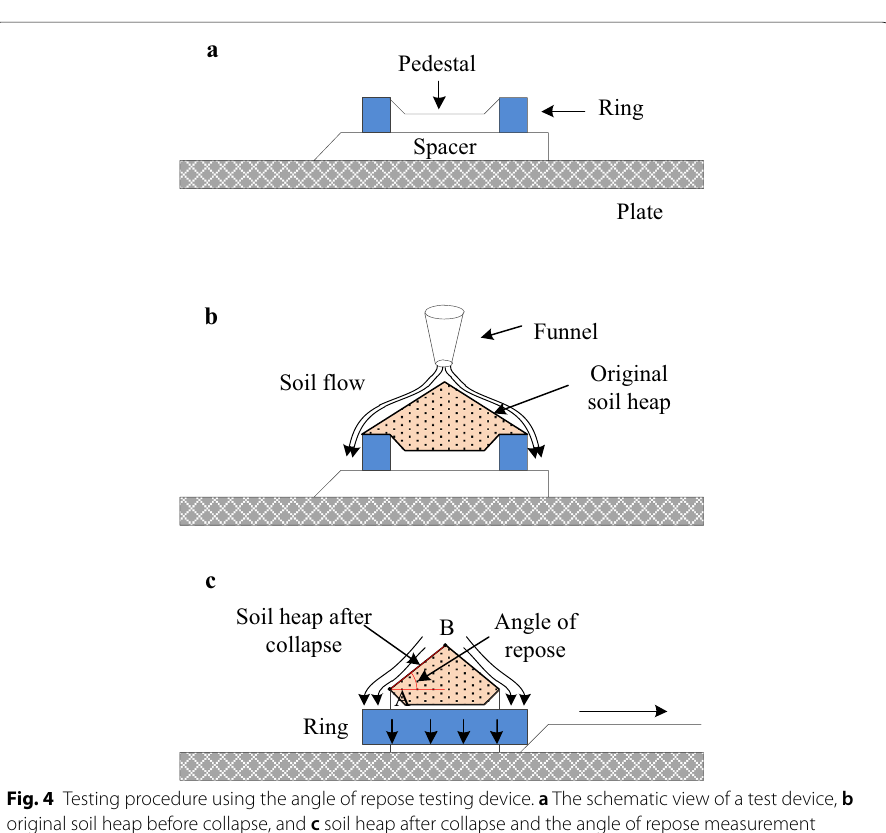
Fig. 4 Testing procedure using the angle of repose testing device. a The schematic view of a test device, b original soil heap before collapse, and c soil heap after collapse and the angle of repose measurement